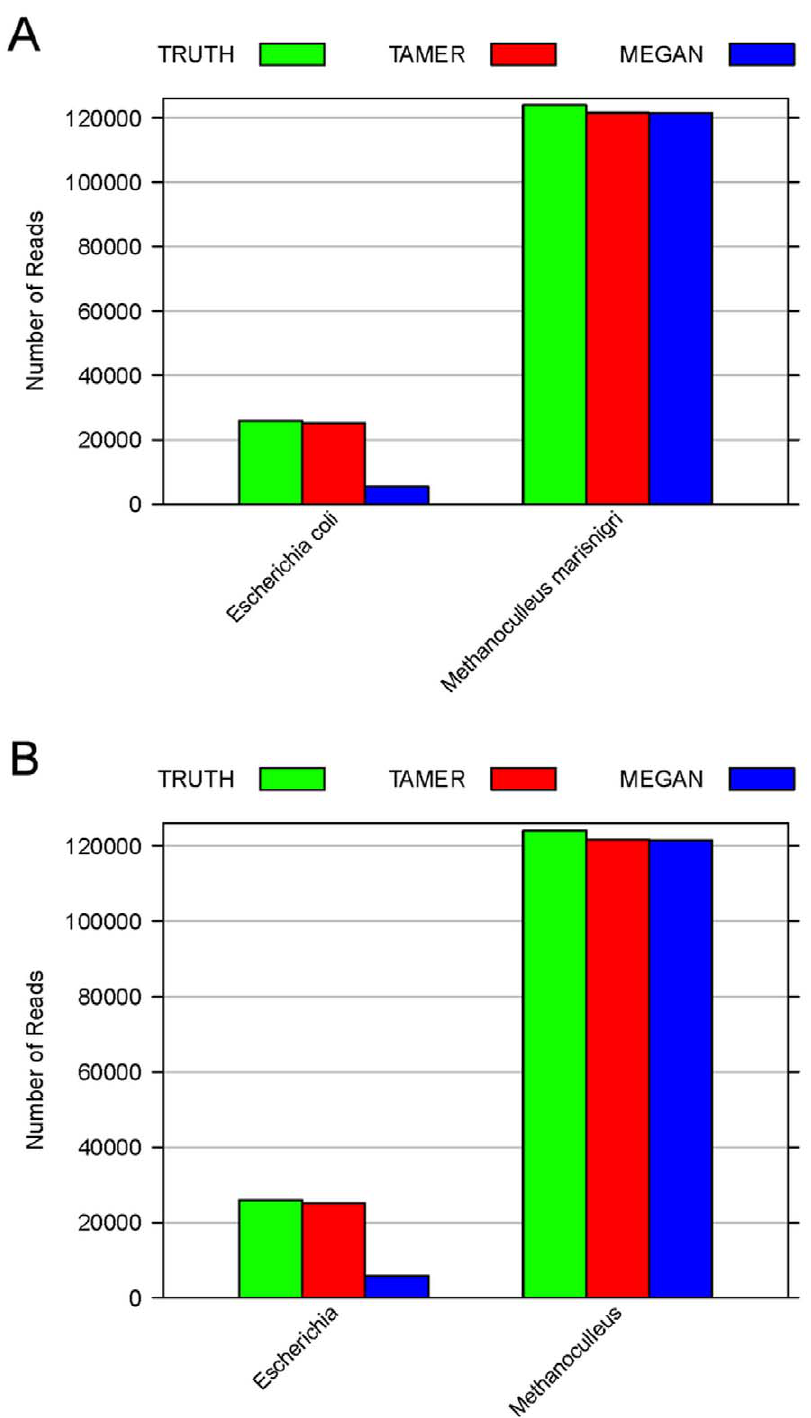
Figure 1. Reads assignment at rank Species and Genus for simLC dataset. Numbers of reads assigned to rank (A) Species and (B) Genus using TAMER and MEGAN are compared with the true values (TRUTH) for the simLC dataset with 150,000 reads and average read length of 100 bp in simulation study 1.